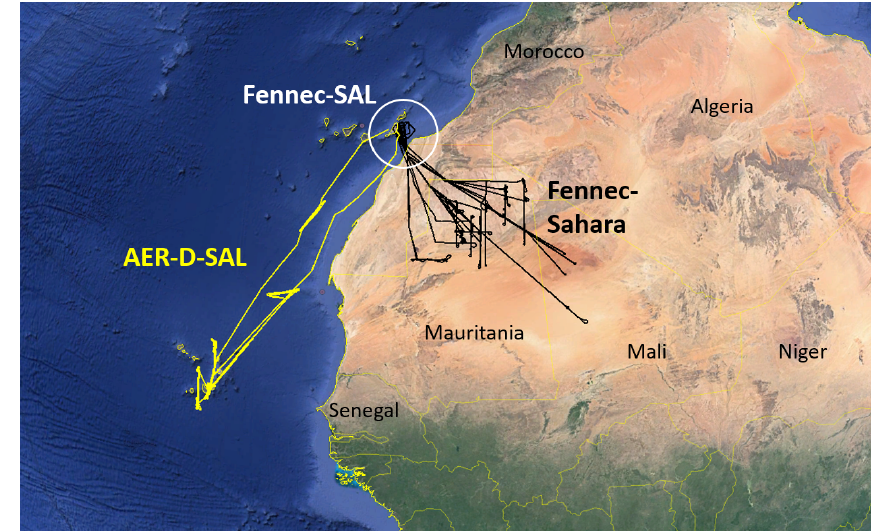
Figure 1. Map showing the locations of research flights: Fennec-Sahara in black, Fennec-SAL in black within the white circle, and AER-D SAL in yellow. Image provided using © Google Earth Pro. Map data: Google, SIO, NOAA, US Navy, NGA, GEBCO, Land- sat/COPERNICUS.